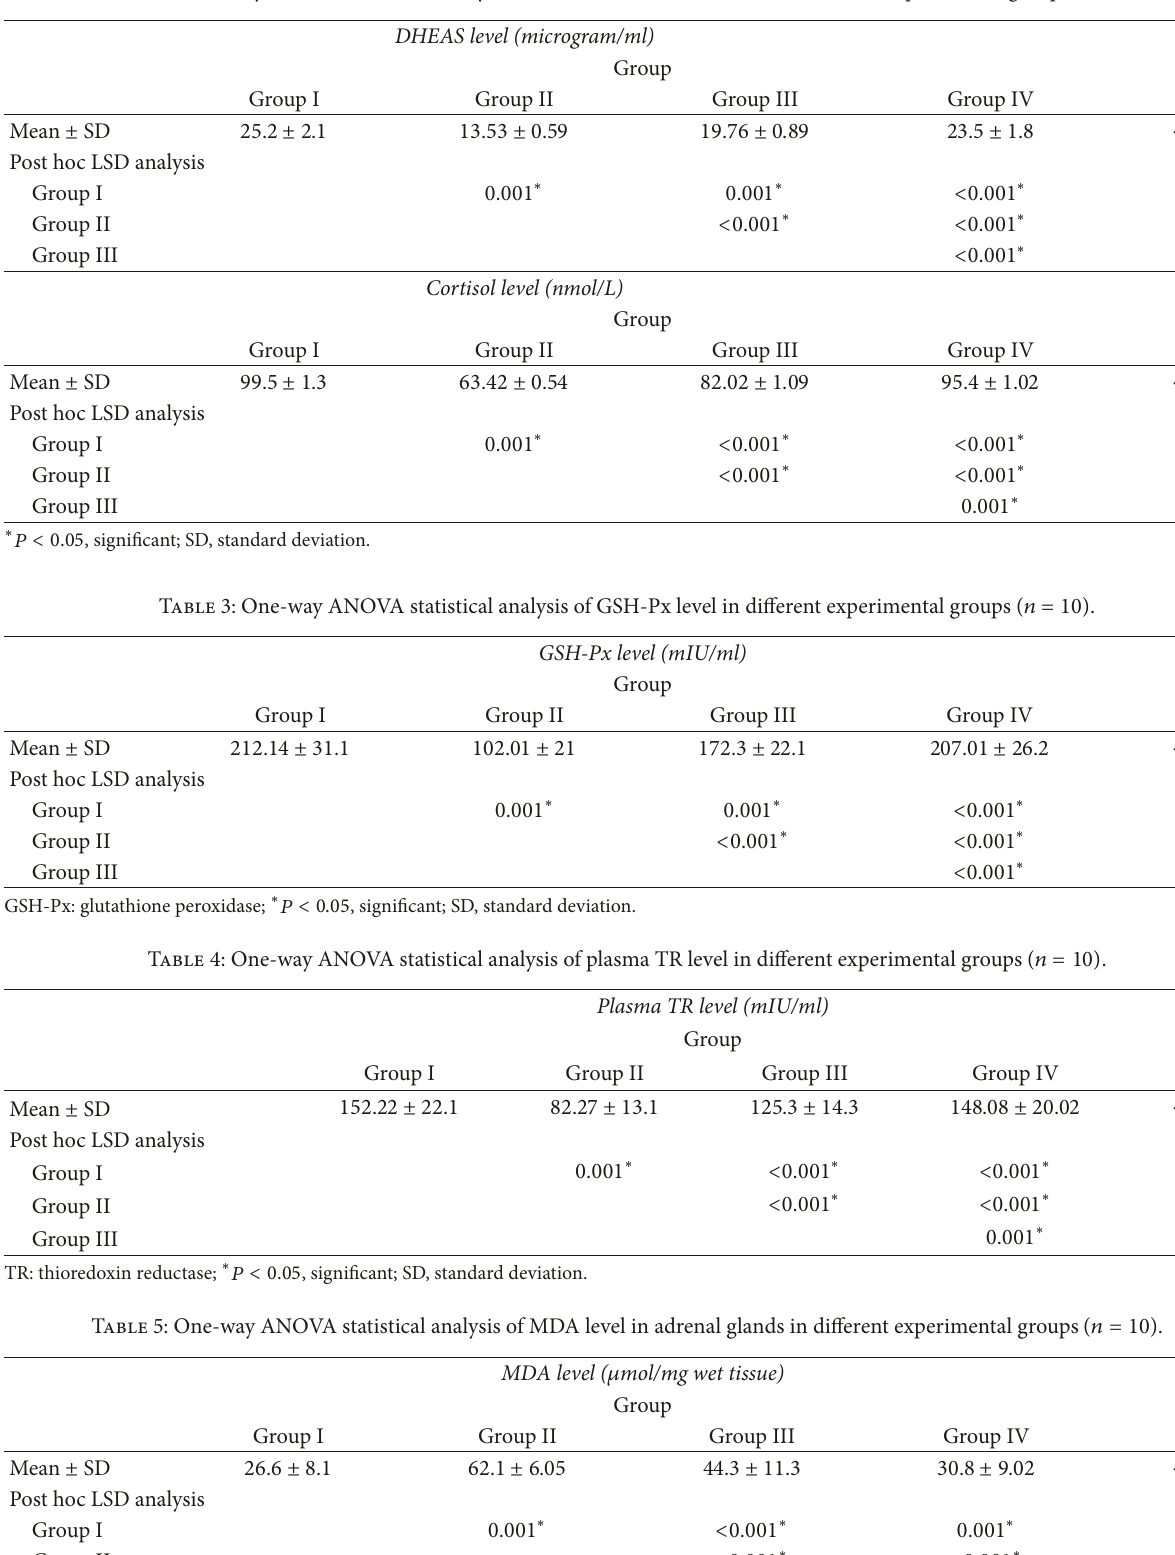
Table 2: One-way ANOVA statistical analysis of cortisol and DHEAS levels in different experimental groups (𝑛 = 10) .